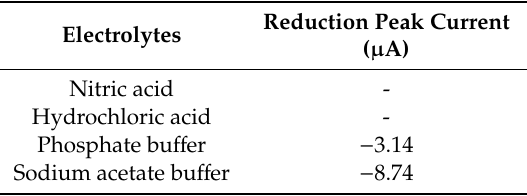
Table 1. The e ff ect of di ff erent electrolytes on the reduction current of Cr (VI).